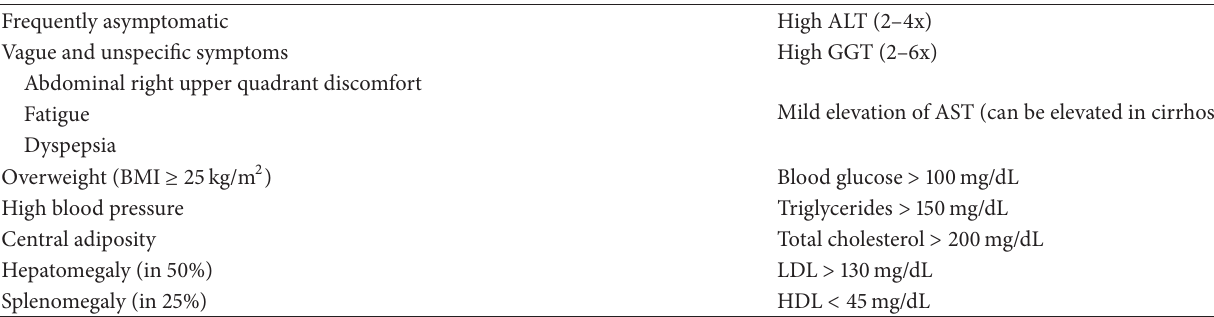
Table 1: Clinical signs and symptoms and laboratory picture of